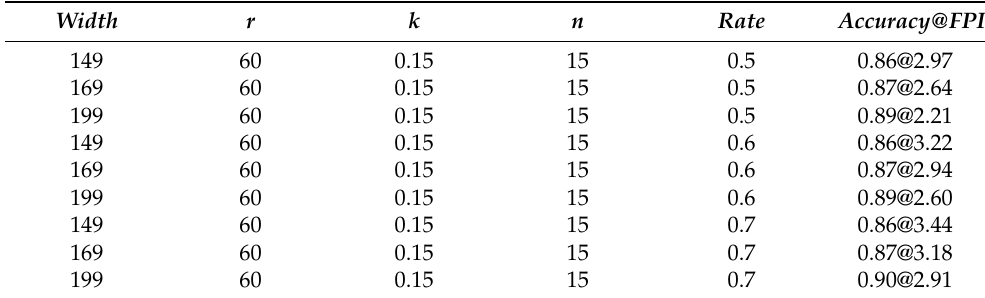
Table 9. Performance of the proposed GFNet framework on CBIS-DDSM parameters with KNN 20 as the classifier of false positive reduction and